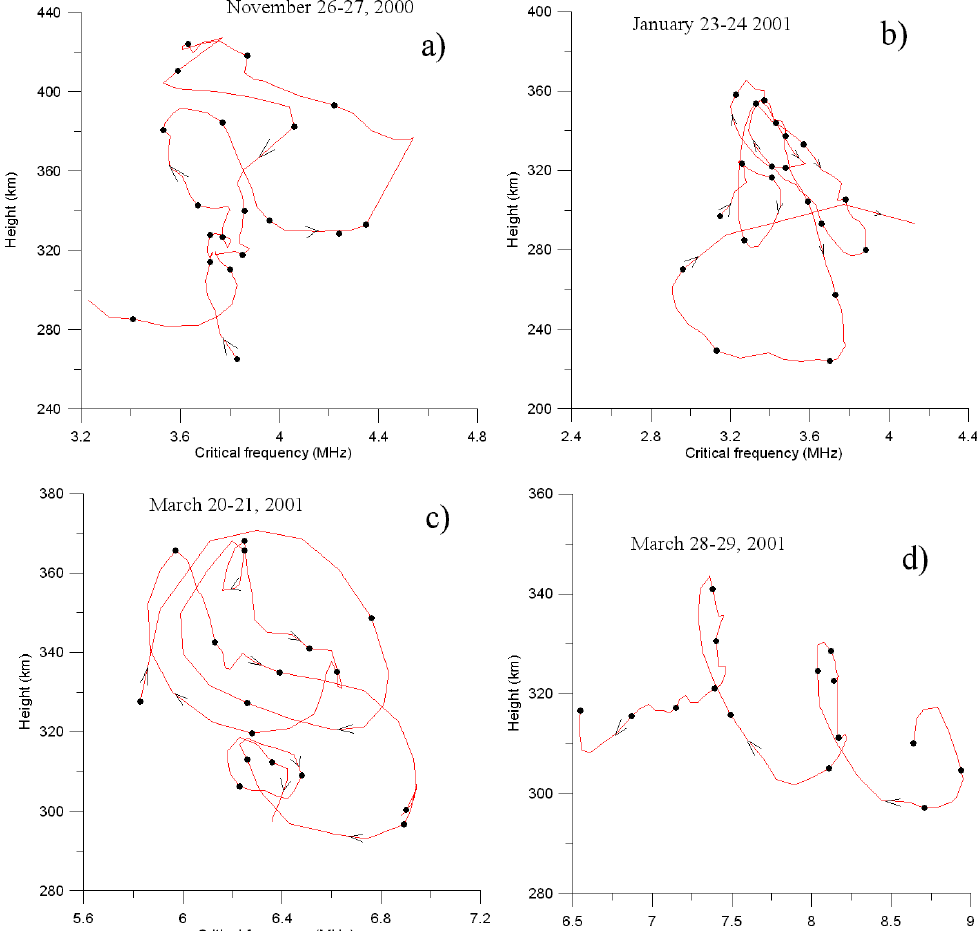
Fig. 3. Typical examples of hodograph show the time evolution of the hm F versus f cr